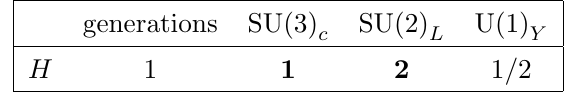
Table 2 . SM scalar sector, containing only the usual Higgs doublet H